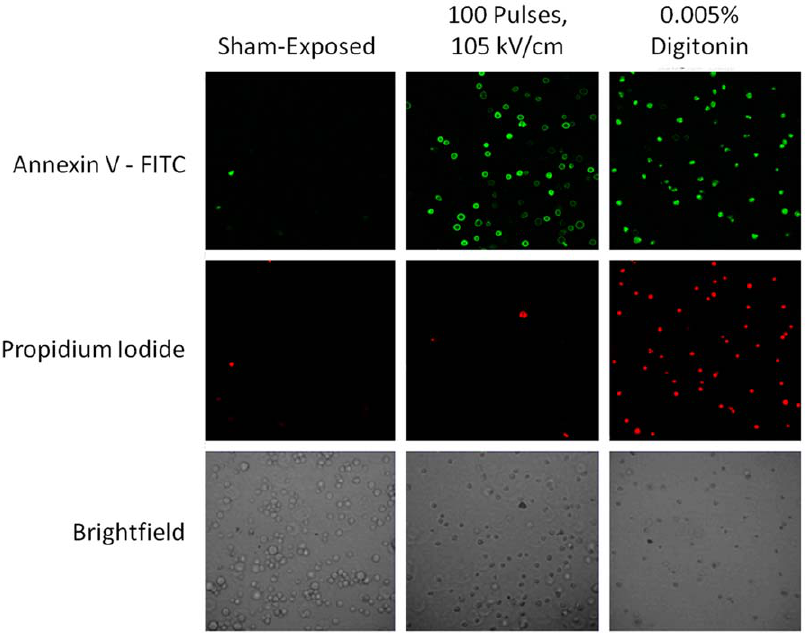
Figure 4. Confocal fluorescent images of Annexin V-FITC expression in USEP-exposed Jurkat. Images detail the fluorescent staining of Jurkat cells following sham-exposure, exposure to 100 USEP at 105 kV/cm, and 0.005% digitonin.